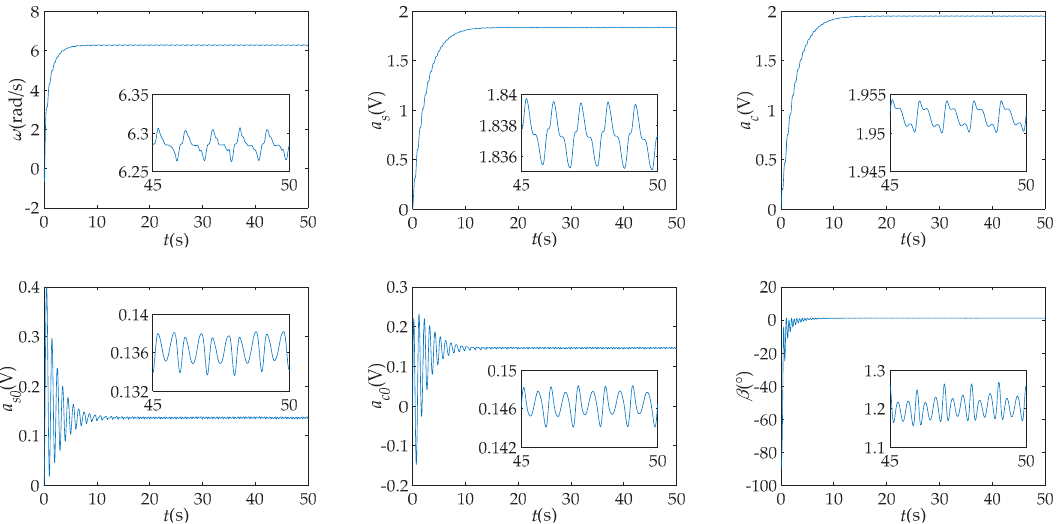
Figure 9. Estimations of angular velocity and imperfect parameters in simulation after the DWT (Group 3).